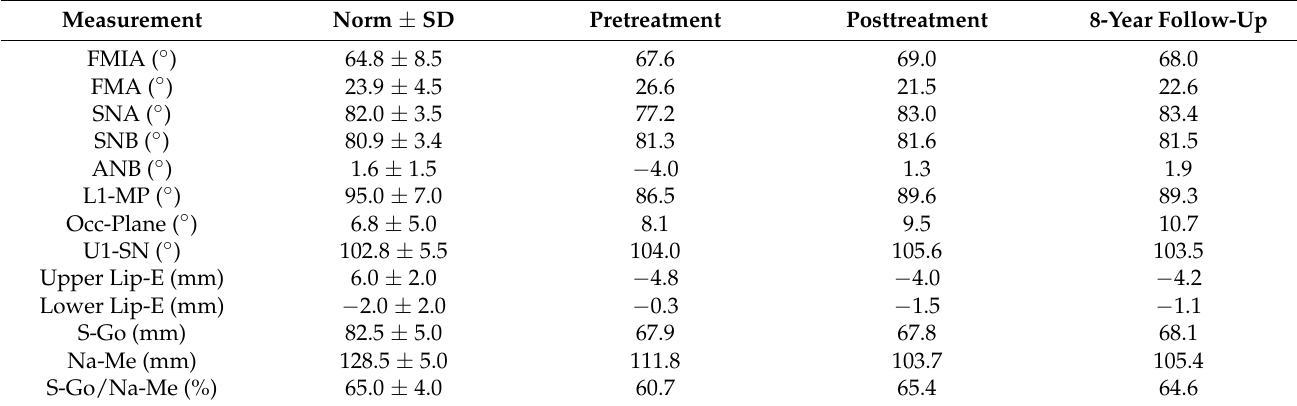
Table 1. Cephalometric